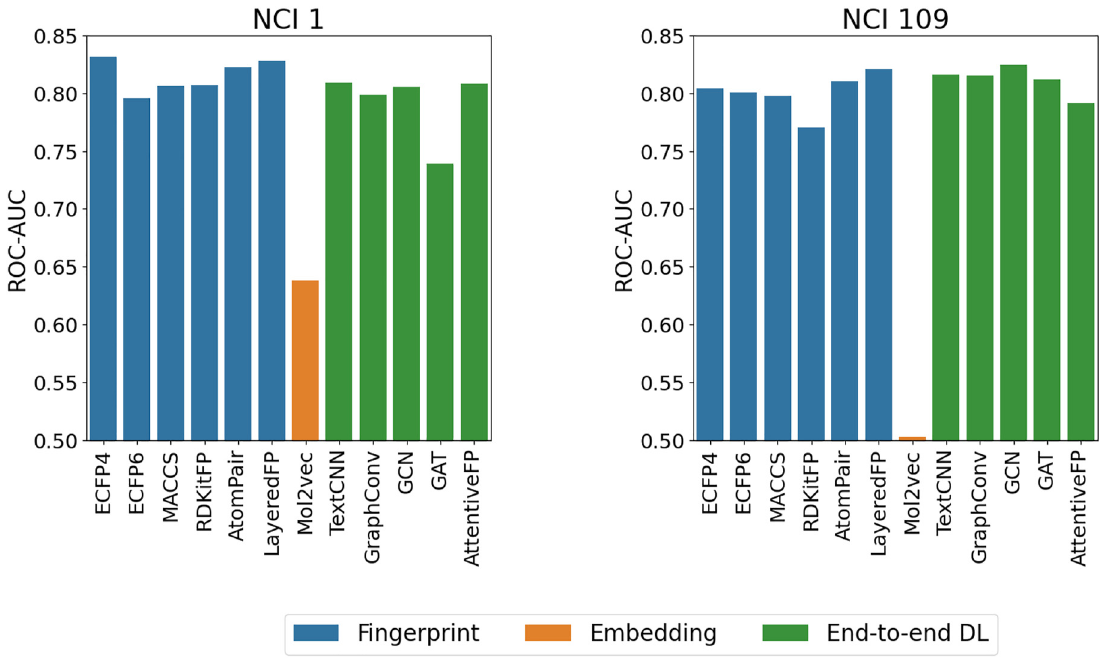
Figure 4: Performance (ROC-AUC) of different deep learning models on the NCI 1 and NCI 109 classification tasks. Higher scores mean better